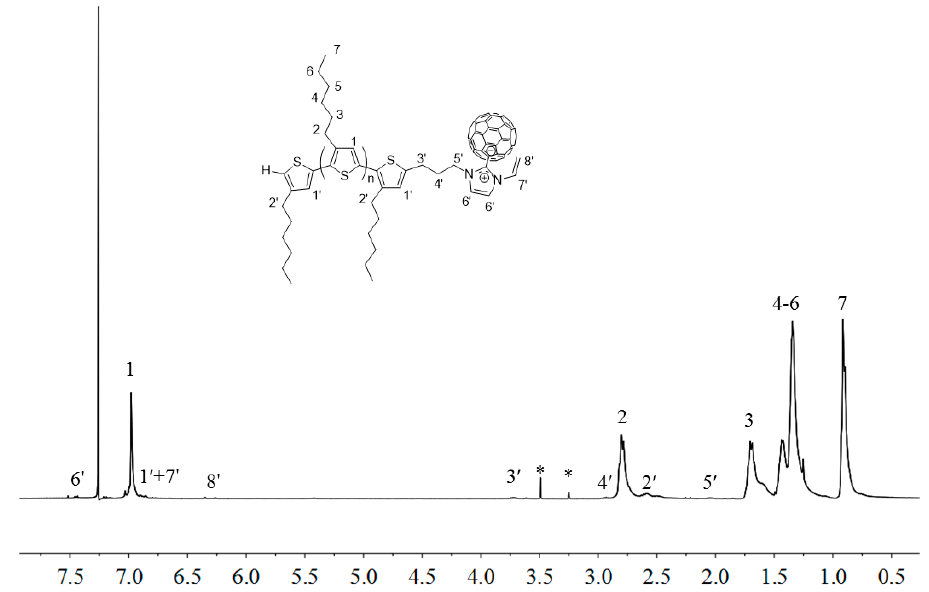
Figure 9. 1 H-NMR (400 MHz, CDCl 3 ) spectrum of P3HT-(CH 2 ) 3 -VIM-C 60 . Peaks marked * correspond to residual solvent signals. The polymer is only marginally soluble in this NMR solvent.